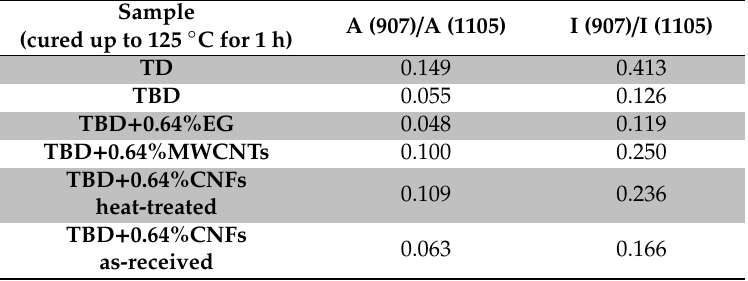
Table 1. Ratios between the areas and the intensities of the peaks at 907 cm − 1 and 1105 cm − 1 for